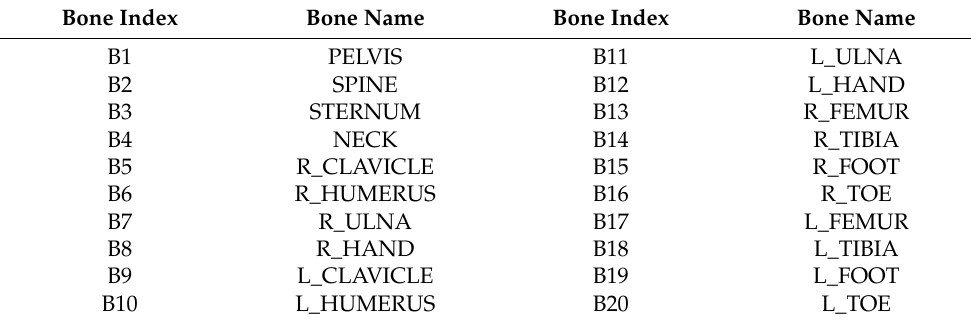
Figure 20. Composition of the human model. Table 4. List of bone names.